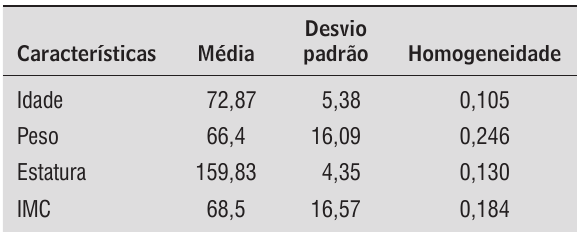
Tabela 1 - Análise descritiva da amostra: idade (anos), peso (kg), estatura (cm) e Índice de Massa Corpórea